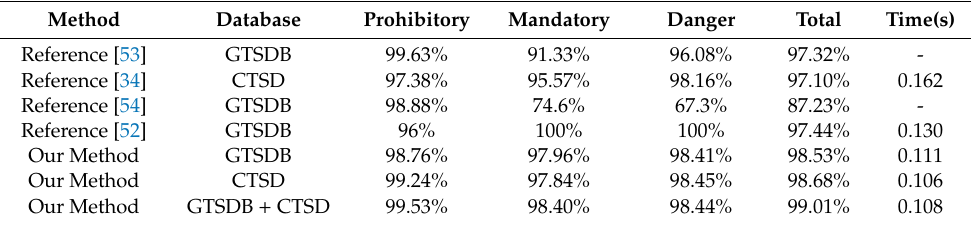
Table 5. The comparison of the precision of the proposed approach with other representative approaches using the German tra ffi c sign detection benchmark (GTSDB) and Chinese tra ffi c sign dataset